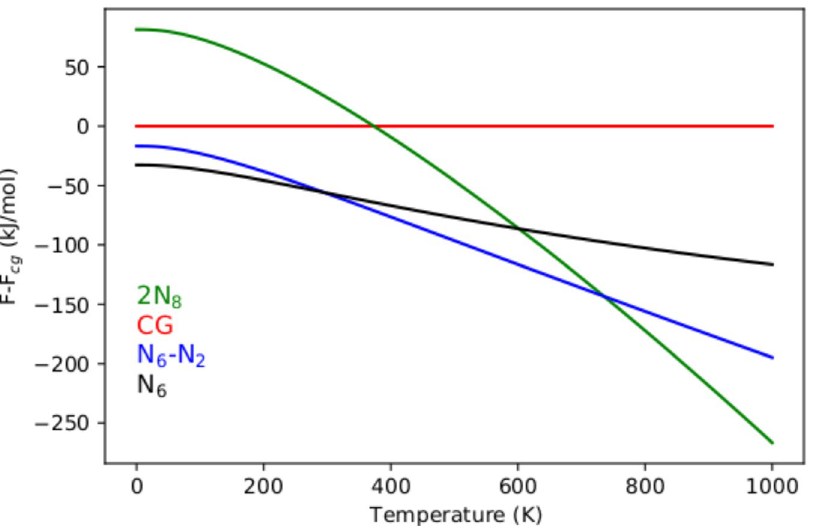
Figure 5. Zero-pressure Helmholtz free energy as a function of temperature for N 6 –N 2 , cg-PN, 2N 8 and N 6 . cg-PN Helmholtz free energy is taken as a reference.